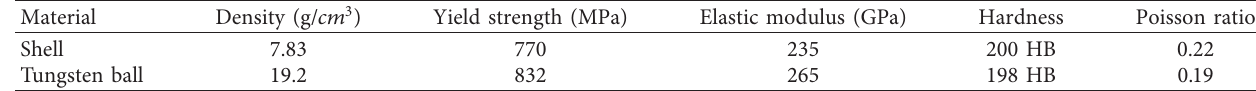
Table 2: Material properties of